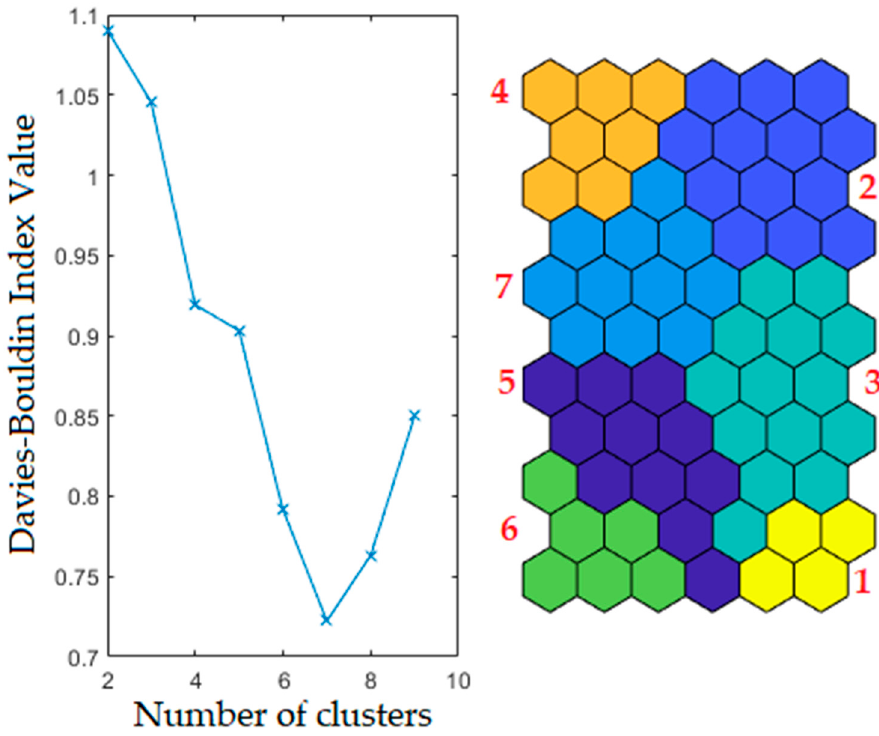
Figure 4. Clustering patterns according to the Davies-Bouldin index minimum value. Among the seven clusters, C_I includes 20 samples (13.4%) with the highest